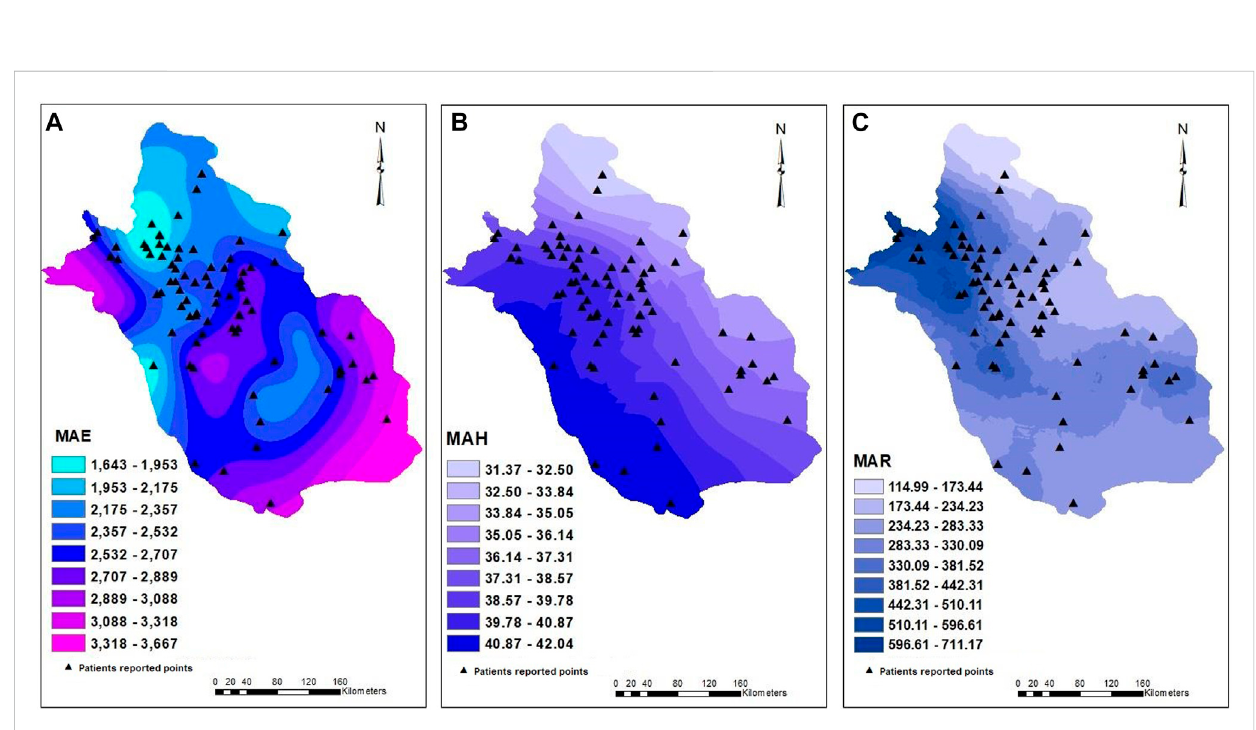
FIGURE 3 Points with acute adult asthma (triangle symbol) located in areas with varied range of MAE (A) , MAH (B) , and MAR (C)